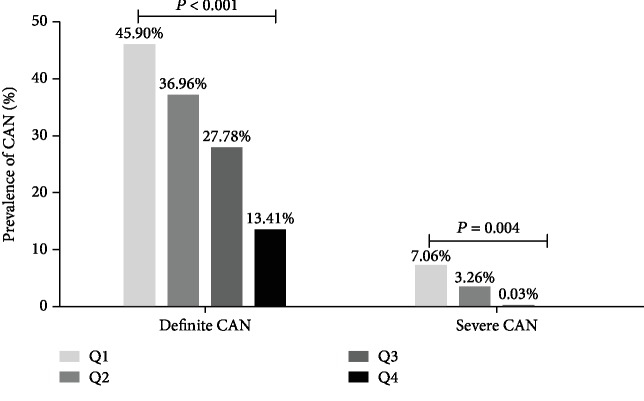
Prevalence of CAN in different quartiles (Q1-Q4) of TIR. aCAN: cardiovascular autonomic neuropathy; bTIR Q1 ≤ 41%, Q2: 41-64%, Q3: 64-83%, Q4 > 83%. cAs shown in this figure, patients were divided into groups according to quartiles of the time in range (TIR), the proportion of definite CAN decreased with the increase of TIR, while a similar decreased was found between the prevalence of severe CAN and quartiles of TIR (P < 0.05). P value for the significant difference among the groups was determined by χ2-test.